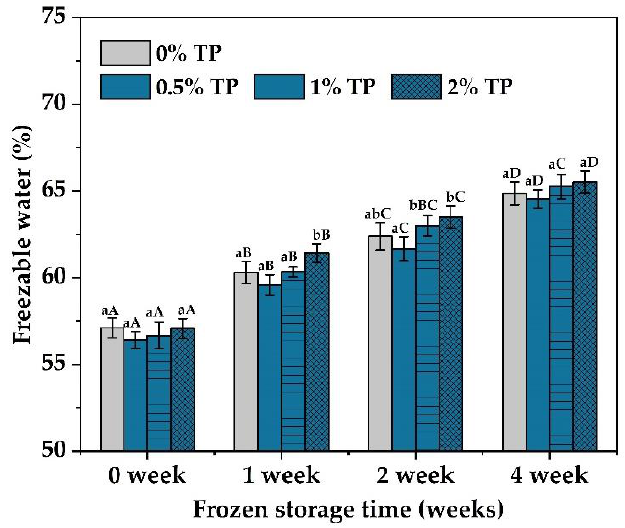
Figure 6. The freezable water content of NFFD (%, wet basis) in the presence of TPs (0–2%) at 0–4 weeks. Values with different lower- or uppercase letters differ significantly among samples either with the same frozen storage time or TP addition ( p < 0.05).